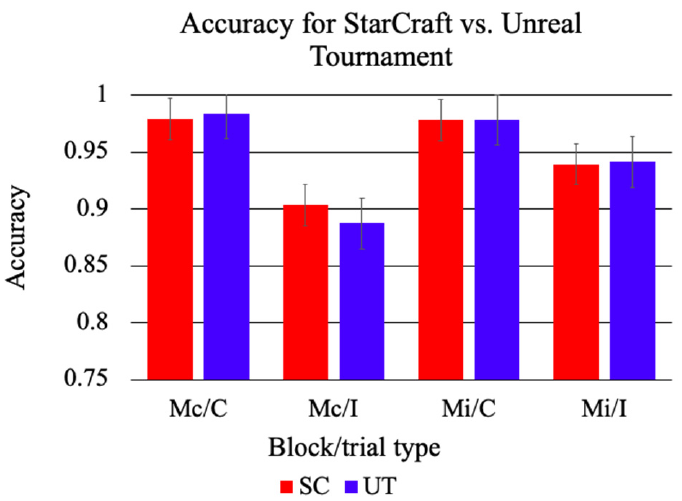
Figure 1. Mean accuracy in the CStroop for SC and UT. The participants in both gaming groups were less accurate for I trials in comparison to C trials. I trials were more accurate in the Mi block than the Mc block. There were no significant